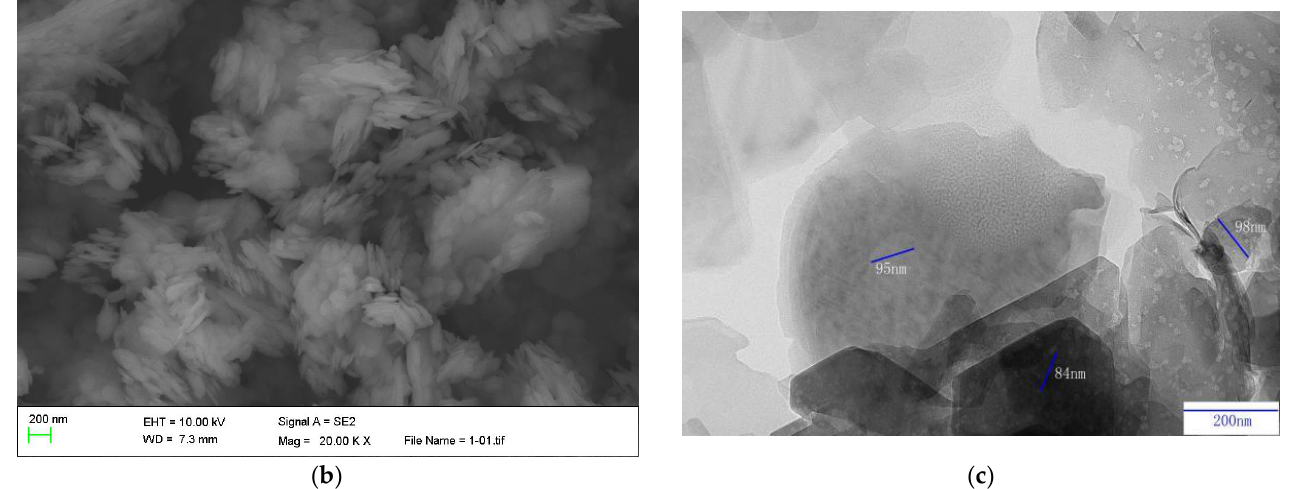
Figure 1. Appearance/SEM/TEM micrographofNMK. ( a ) Appearance; ( b ) SEM; ( c ) TEM.